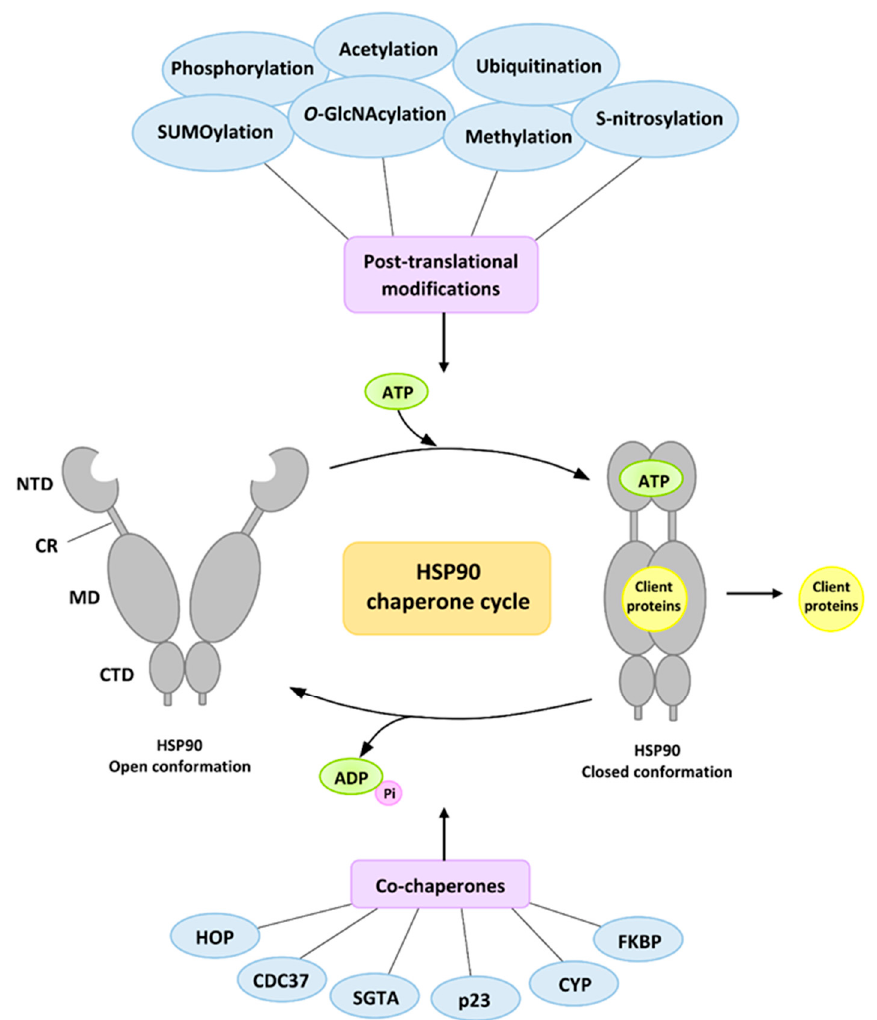
Figure 3. The HSP90 chaperone cycle. At the beginning of the cycle, HSP90 has an open conformation, and only the C domain dimerizes. ATP binding and an ordered series of conformational changes allow it to adopt a closed conformation, which is N-terminally dimerized. After ATP hydrolysis, HSP90 returns to the open conformation and is ready to begin another ATPase cycle. During the chaperone cycle, the client proteins are activated. This cycle is tightly regulated by various post-translational modifications and the action of the co-chaperones proteins.